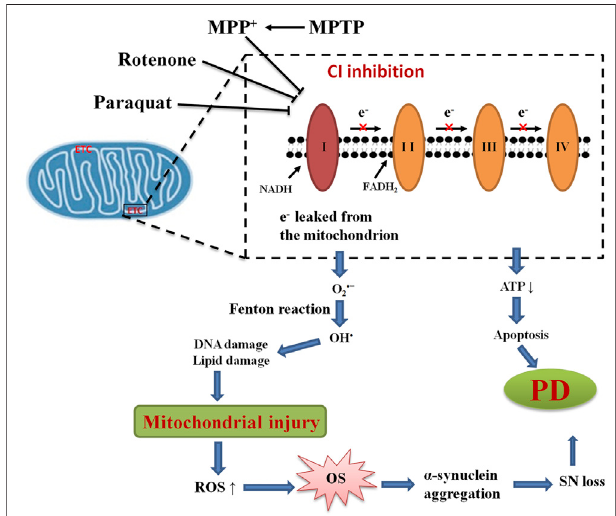
FIGURE 3 | Mitochondrial dysfunction and OS in PD. The mechanism of mitochondrial dysfunction and OS highlights the inhibition of mitochondrial complexI(CI)andassociatedROSproductionleadingtolossofdopaminergic neurons in PD.